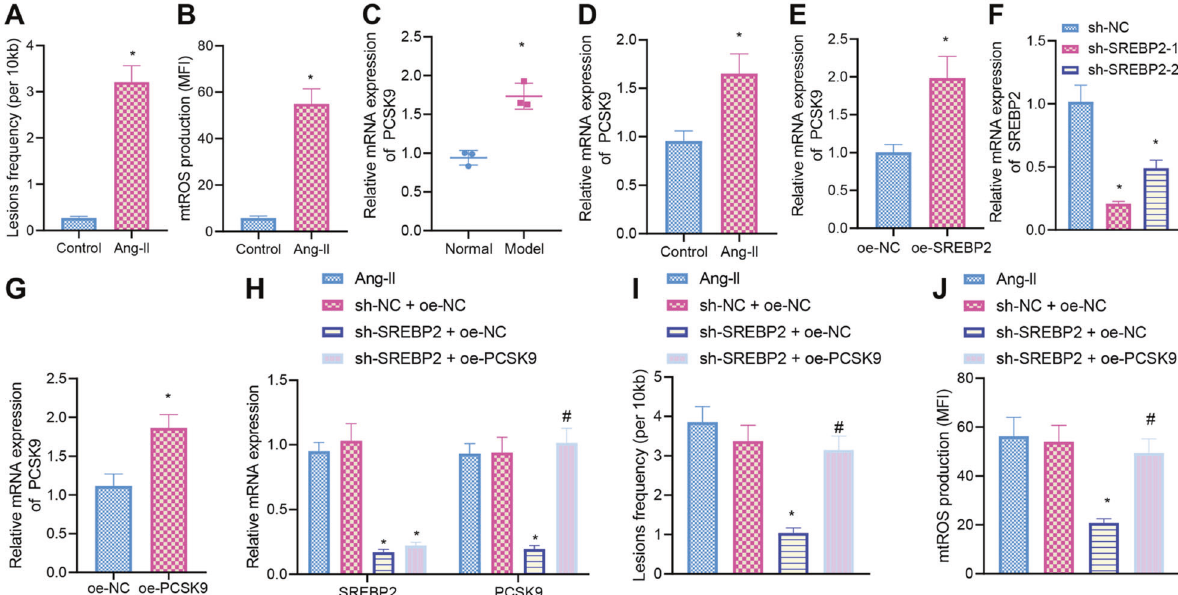
Fig. 5 SREBP2 facilitates mtDNA damage by augmenting PCSK9 expression in vitro. A mtDNA damage measurement in control and Ang II- induced HL-1 cells. B mtROS production measurement in control and Ang II-induced HL-1 cells. C RT-qPCR detection of PCSK9 expression in atrial tissues of normal and Ang II-treated mice. D RT-qPCR detection of PCSK9 expression in control and Ang II-induced HL-1 cells. E RT-qPCR detection of PCSK9 expression in HL-1 cells treated with oe-SREBP2. F RT-qPCR detection of SREBP2 expression in HL-1 cells treated with sh- SREBP2-1 or sh-SREBP2-2. G RT-qPCR detection of PCSK9 expression in HL-1 cells treated with oe-PCSK9. H RT-qPCR detection of SREBP2 and PCSK9 expression in HL-1 cells treated with sh-SREBP2 or combined with oe-PCSK9. I mtDNA damage measurement in HL-1 cells treated with sh-SREBP2 or combined with oe-PCSK9. J mtROS production measurement in HL-1 cells treated with sh-SREBP2 or combined with oe-PCSK9. * p < 0.05, compared with the normal mice, control HL-1 cells, Ang II-induced HL-1 cells treated with sh-NC, oe-NC or sh-NC + oe-NC. # p < 0.05, compared with the Ang II-induced HL-1 cells treated with sh-SREBP2 + oe-NC. All experiments were repeated three times independently. n = 10 for mice in each